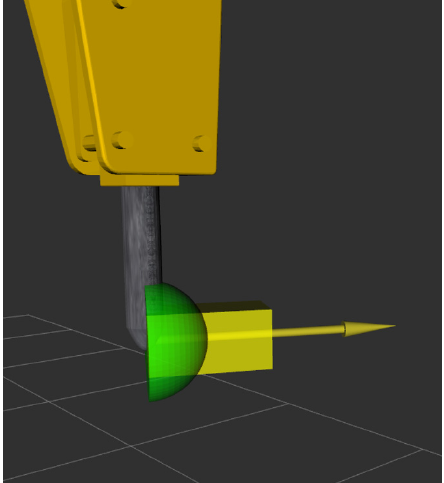
Figure 10. The yellow arrow shows the direction that the end-effector is moving. The yellow cuboid and green half-sphere are oriented according to the direction of motion of the effector. As mentioned, the intersection of the virtual collision region with the collision point cloud will indicate how close is the effector to collide if the current direction and velocity of movement are maintained. The orientation of the virtual collision region has a direct relation to the direction of displacement of the end-effector, and the region it represents indicates the possible future positions in which the effector will find itself in future time